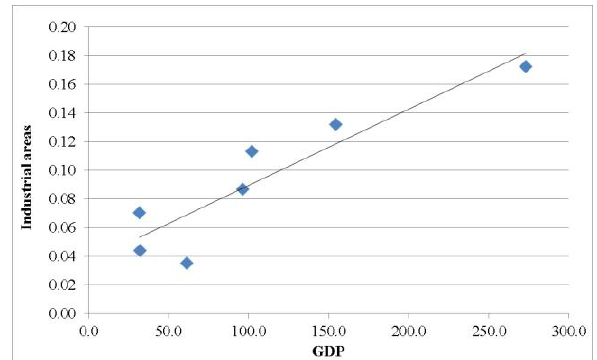
Figure 19. Relationship between GDP and Industrial areas for 2005 ( R 2 = 0.73)